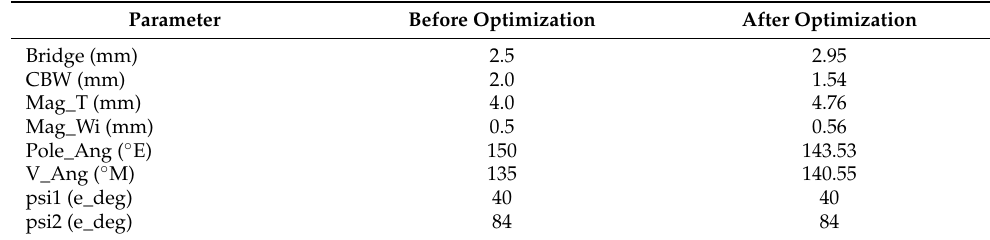
Table 7. Output parameters after